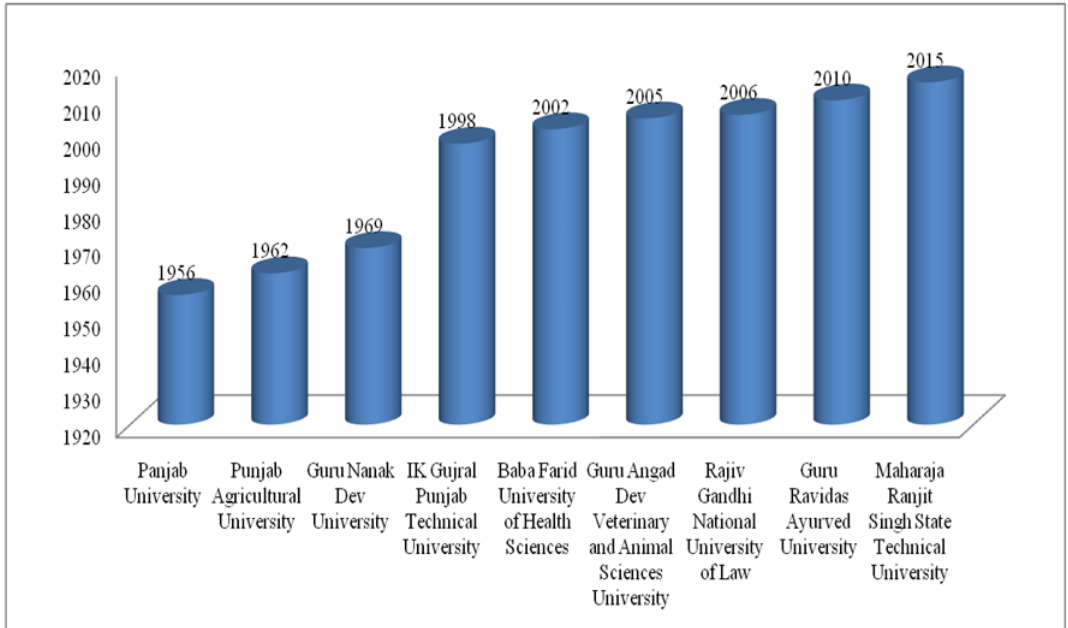
Figure 6. Government Universities in